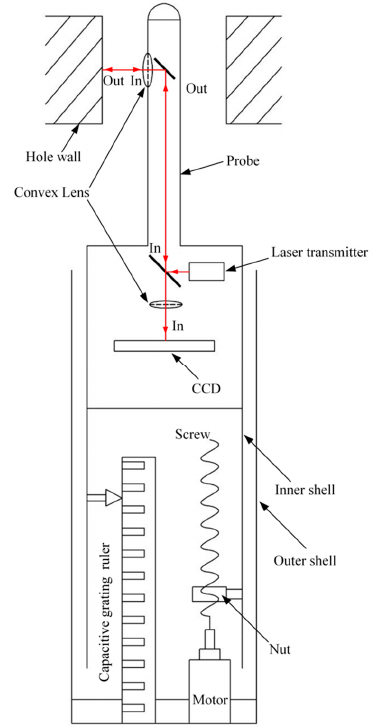
Figure 5. Schematic diagram of equipment structure design.